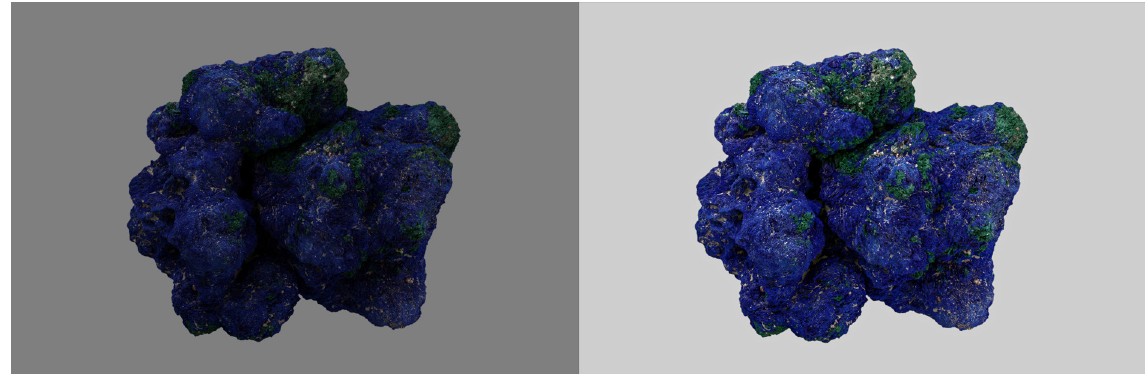
Fig. 5.1. Relighting in DxO OpticsPro 11. The original image is on the left, the post-processed picture on the right. The underexposed image is now corrected without the need to take new